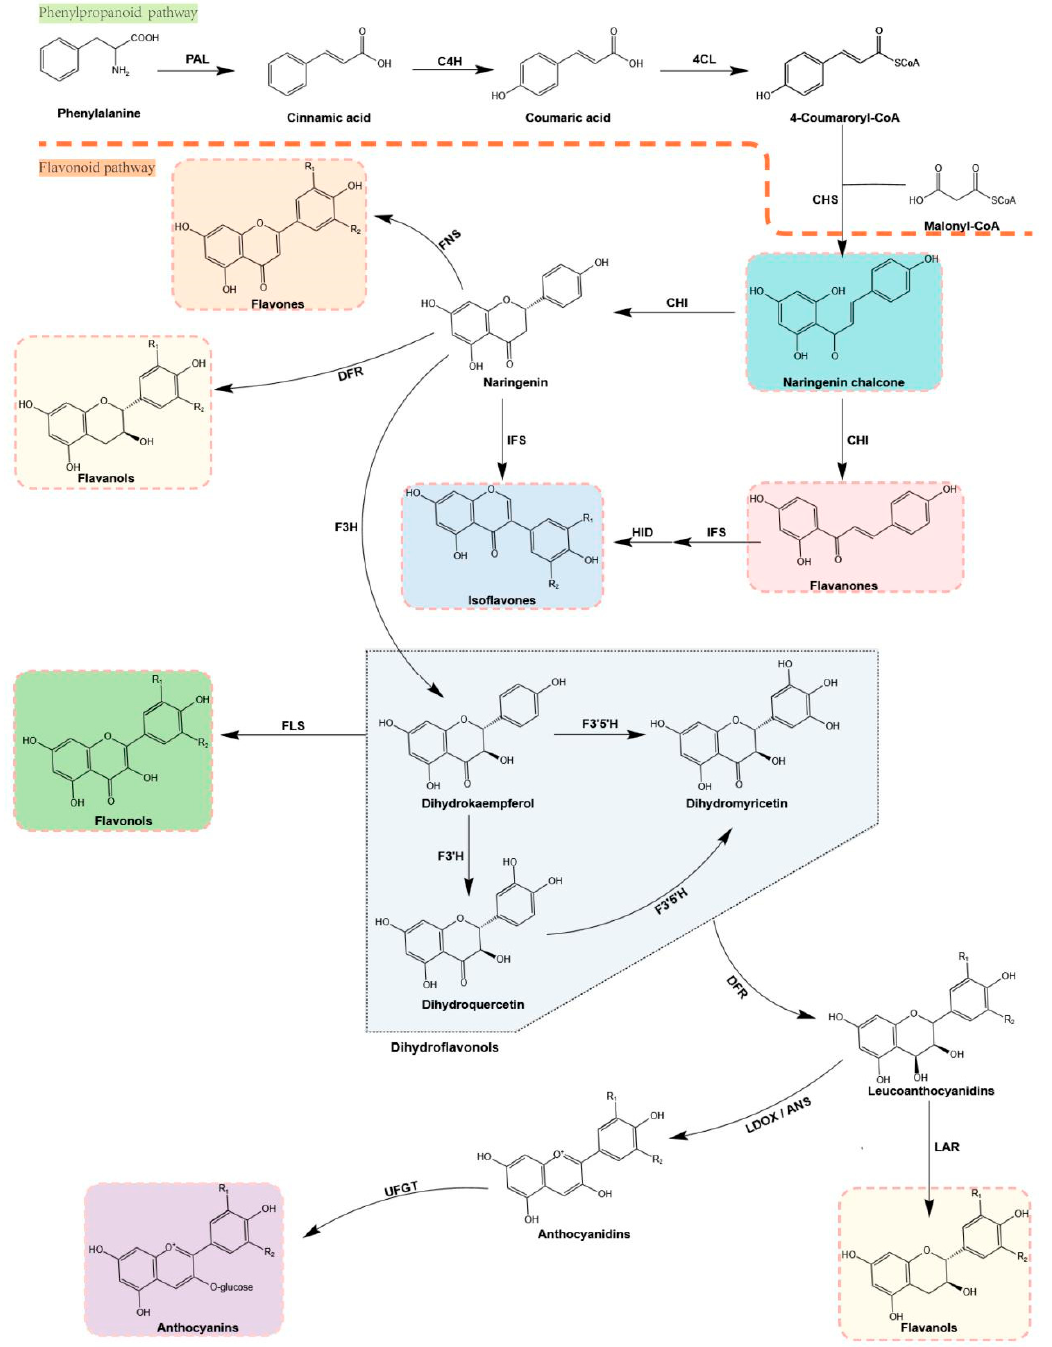
Figure 2. The pathway of flavonoid